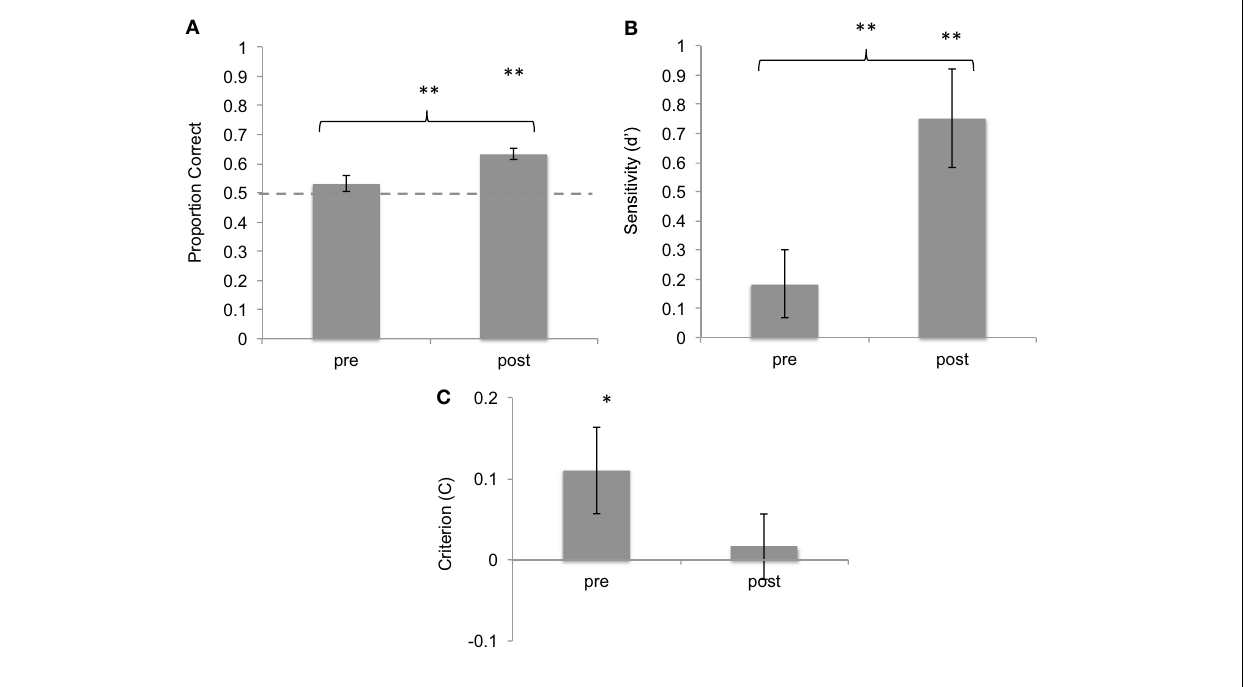
same responses, showing improvement in sensitivity. (C) Criterion values of the same data, showing reduction in bias. * p < 0.05; ** p < 0.01. Error bars reflect between-subject standard